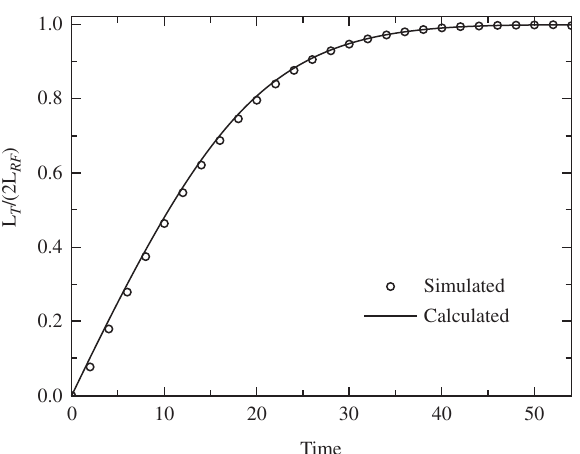
/(2 L ) against time. T RF